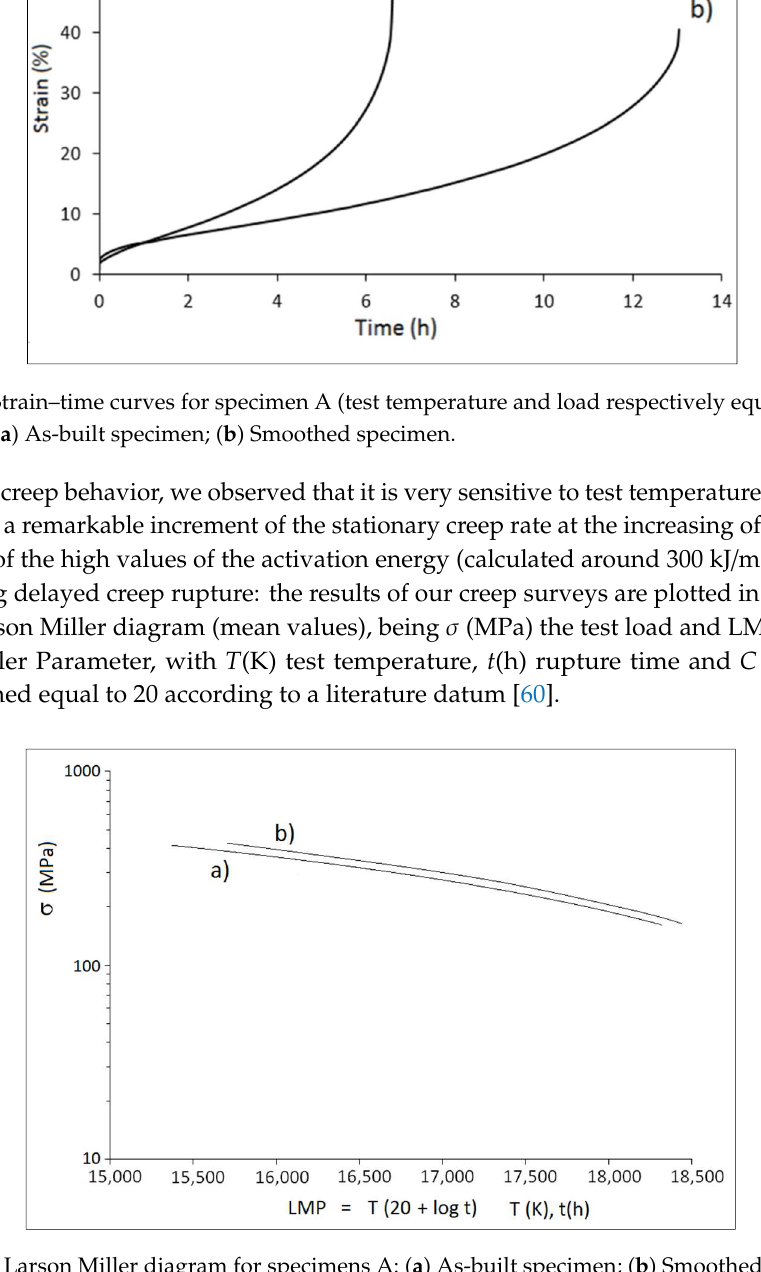
Figure 16. Scanning electron microscopy (SEM) micrographs of a fracture surface obtained by tensile test at room temperature.